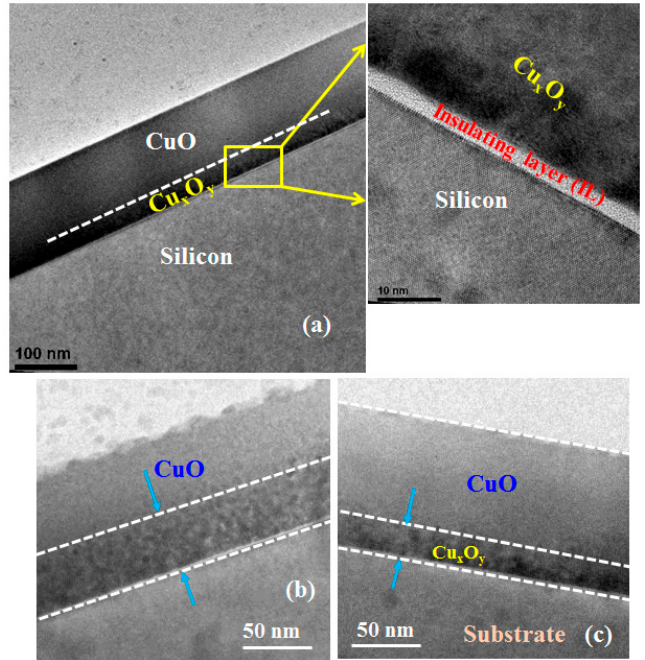
Figure 7. Cross-sectional TEM of p-CuO/n-Si heterostructure. Sputter deposited CuO at 150 W on n-Si substrate for ( a ) as-deposited; and ( b ) after thermal treatment at 300 °C for 1 min; ( c ) CuO deposited at 50 W sputtering power and annealed at 300 °C for 1 min.